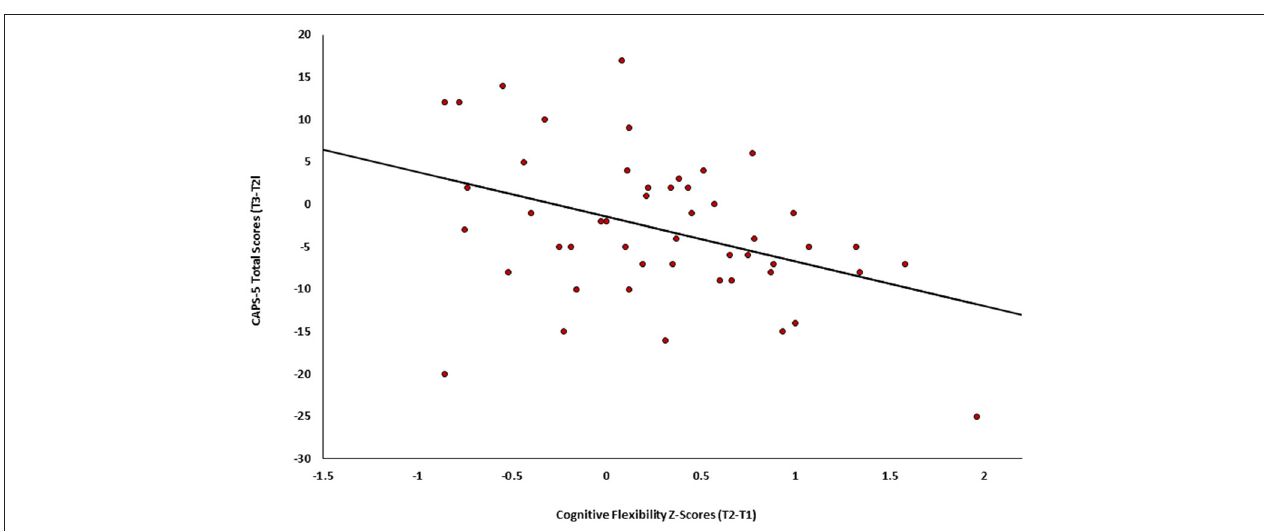
Frontiers in Psychiatry |